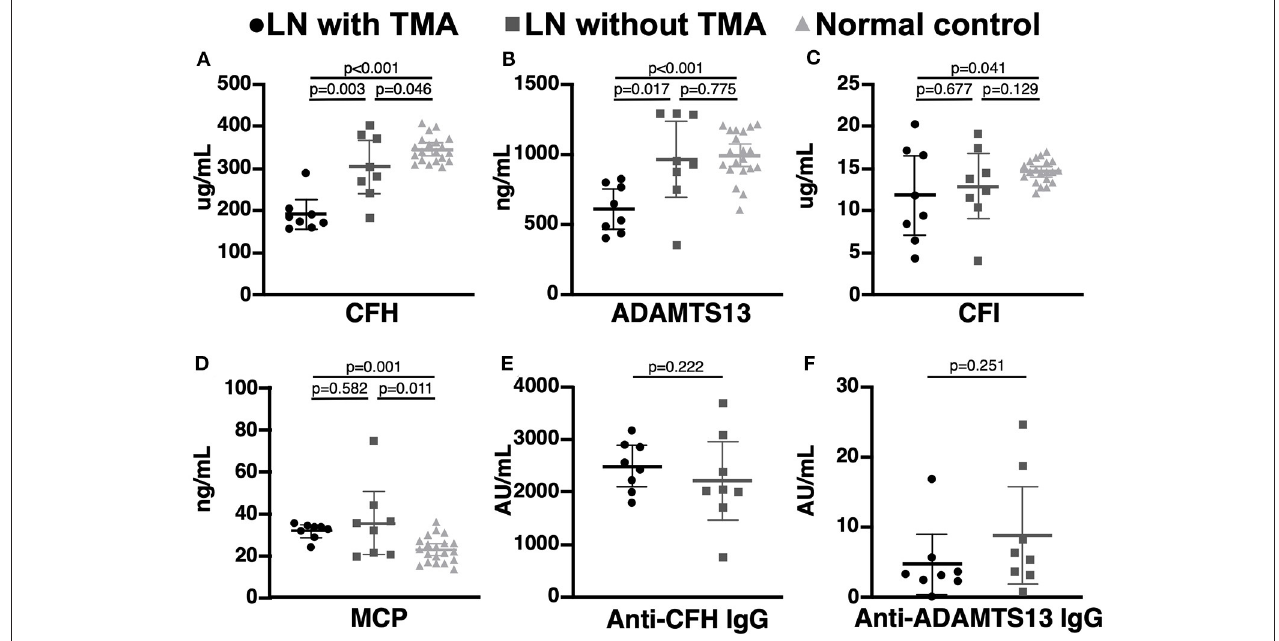
FIGURE 2 | Complement and coagulation studies in normal subjects, lupus nephritis patients with and without renal thrombotic microangiopathy. (A,B) The serum CFH and ADAMTS13 levels were significant lower in lupus nephritis (LN) patients with thrombotic microangiopathy (TMA) than those without TMA and normal subjects. (C,D) LN patients with TMA have statistically lower CFI and MCP levels than normal subjects. (E,F) There was no significant difference in serum anti-CFH and anti-ADAMTS13 antibodies between LN patients with and without TMA.